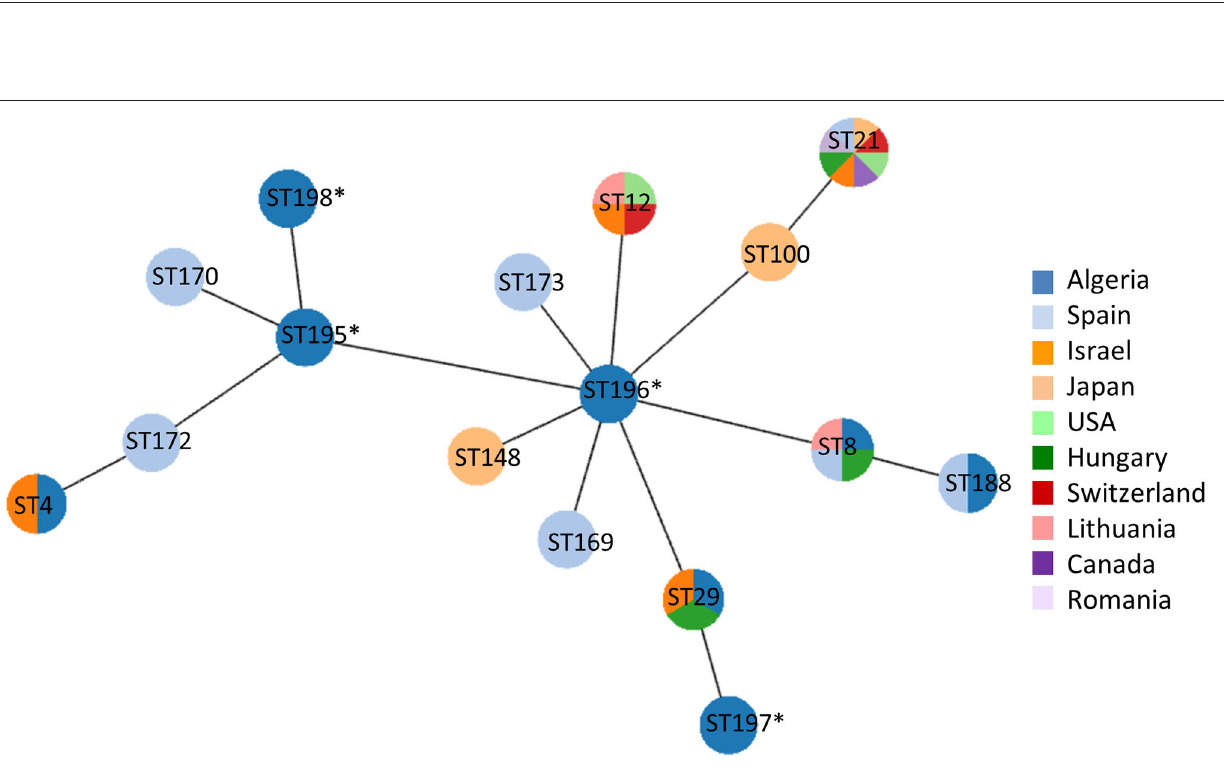
Frontiers in Veterinary Science |